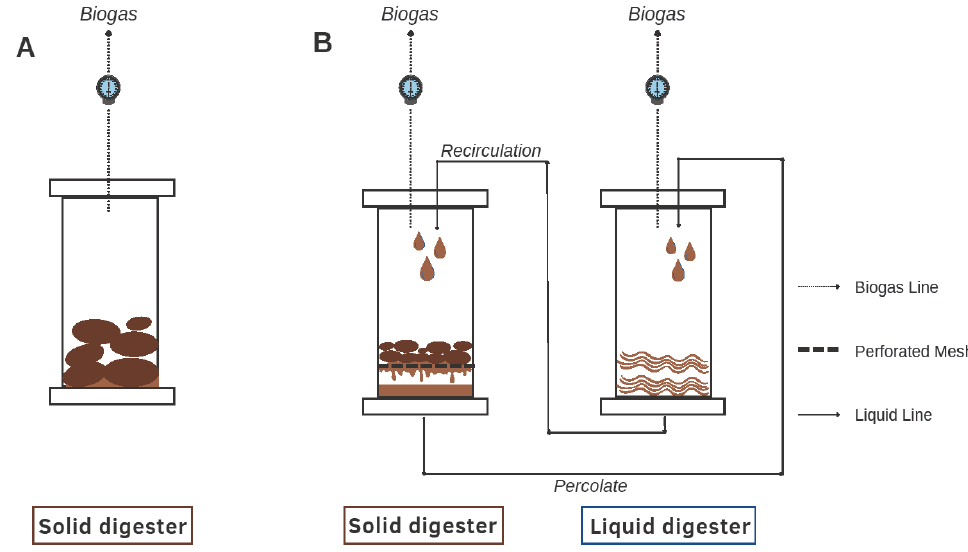
Figure 1. Schematic diagram of experimental set-up for ( A ) single-stage AD system with a static